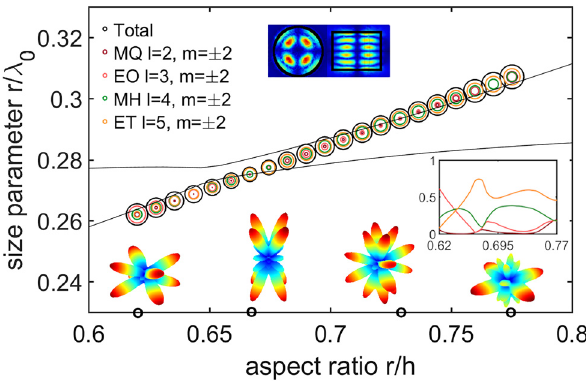
Figure 4: Colored circles trace dispersion of the eigenmode of the AlGaAs disk at the second-harmonic frequency (similar to Figure 2, its wavelength is doubled). Sizes of circles scale the total radiative decay (black) and partial multipolar contributions, also plotted as lines in the inset. Black solid lines are dispersion curves of the fundamental-frequency eigenmodes from Figure 2. Insets show the near- fi eld distribution of the electric fi eld magnitude at r / h = 0.729 (top and side views in the upper image) and far- fi eld diagrams at r / h = 0.62, 0.667, 0.729 and 0.775 (the bottom row). E/M – electric/ magnetic multipoles, Q – quadrupole, O –